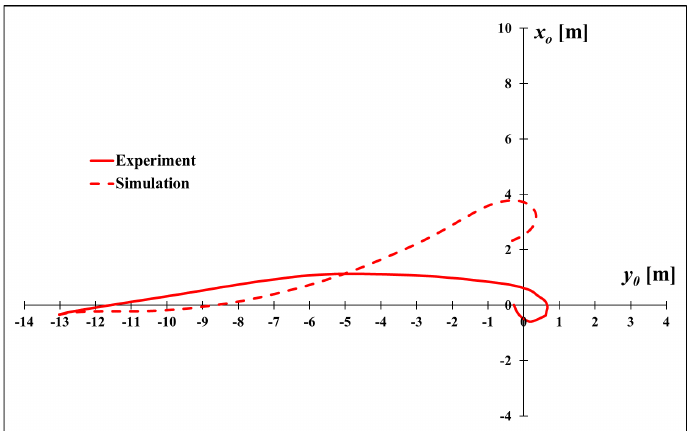
Figure 18. Comparison of experiment and simulation when the initial heading angle is 45 degrees.